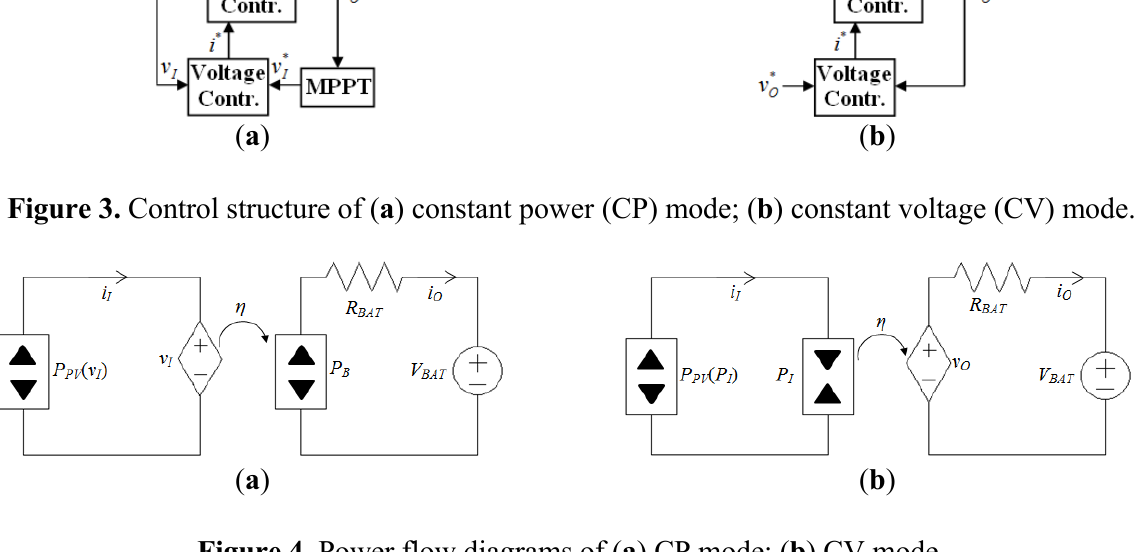
Figure 4. Power flow diagrams of ( a ) CP mode; ( b ) CV mode.